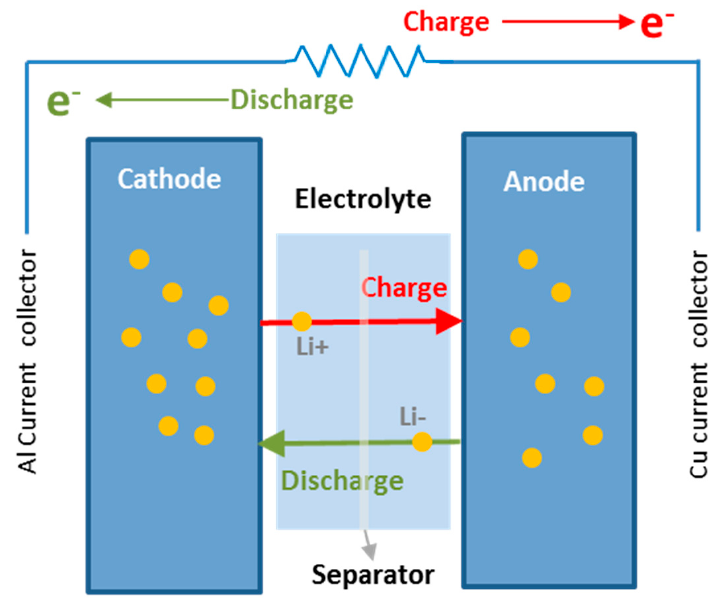
Figure 1. Configuration and operating principle of a lithium-ion battery.